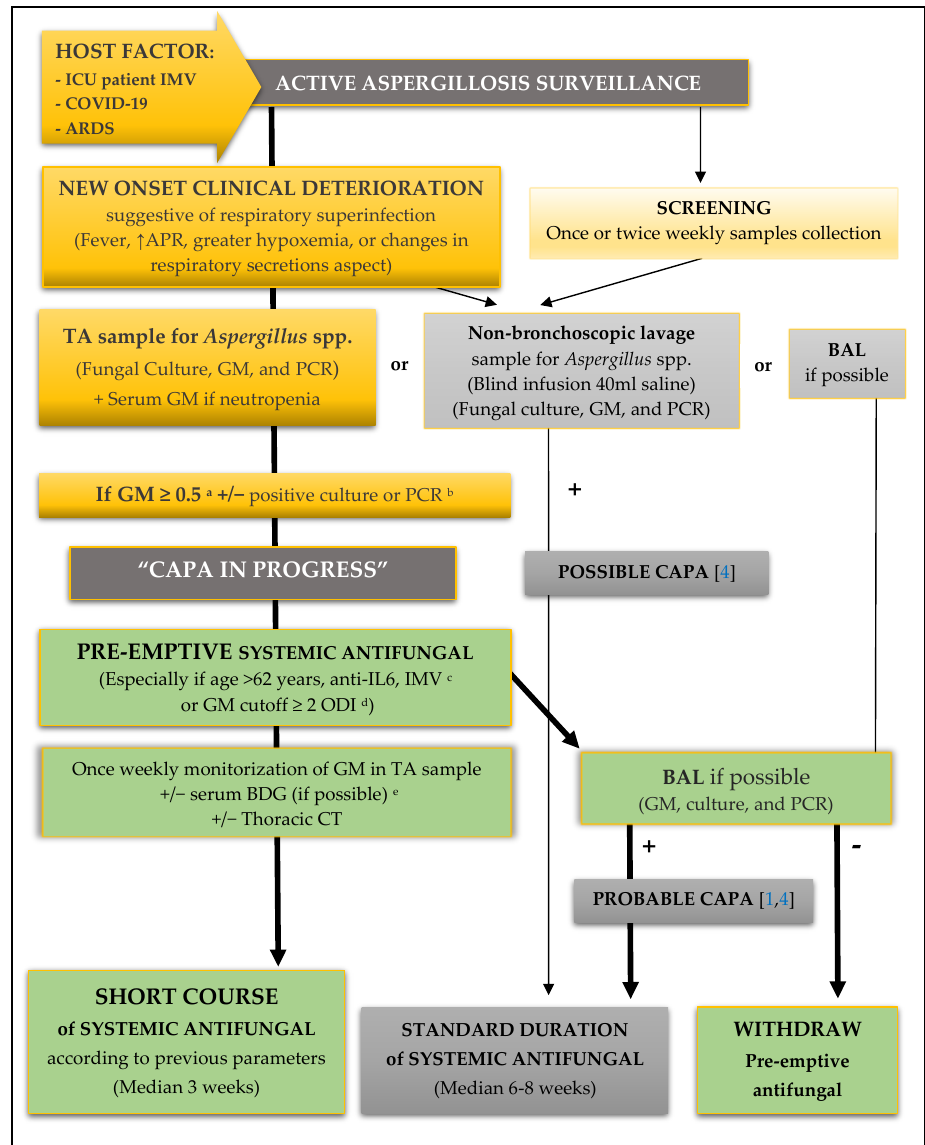
Figure 2. Algorithm for diagnosis and management of “CAPA in progress” in patients admitted to ICU diagnosed with COVID-19 pneumonia and ARDS requiring IMV. Possible approaches depend on hospital characteristics. The protocol followed in our study is shown on the left side while the previously described screening protocols on the right one [5,6,10]. Key aspects supporting our protocol in the algorithm are: a GM from TA is a subrogate of the emerging invasive process as the antigen is released during active fungal growth, providing the pathophysiologic basis of the CAPA-IP concept [8]. b Detection of Aspergillus spp. in respiratory samples (TA) by culture or PCR is associated with mortality [10]. c These three factors were independently associated with proven, probable, or possible CAPA in two large cohorts of critically ill patients diagnosed with COVID-19 pneumonia and ARDS [10,13]. d Diagnostic performance of GM in TA is improved using a cutoff value of 2 ODI, with a negative predictive value (NPV) of over 90% for CAPA probable diagnosis [6]. e Mean serum BDG value in patients with proven and probable invasive fungal disease is significantly higher than in those with fungal colonization, with an NPV of 83% [14]. ICU: intensive care unit; IMV: